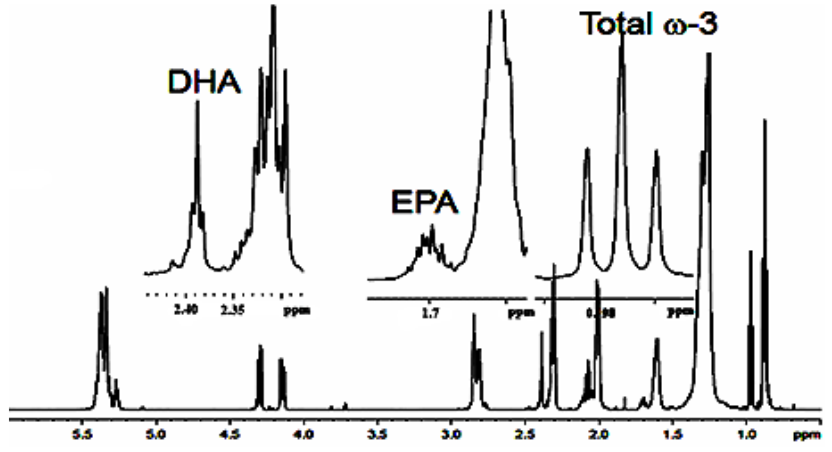
Figure 23. 1 H-NMR spectrum of a salmon oil which allows the simultaneous detection and quantification of ω -3, EPA and DHA. Free download from: http://www.ilps.org/index.php/ Standardized_Methods.html.